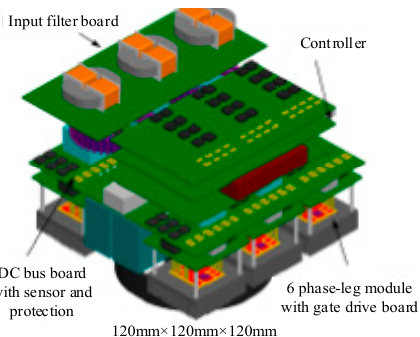
Figure 13. Conceptual drawing and the assembled prototype rectifier system